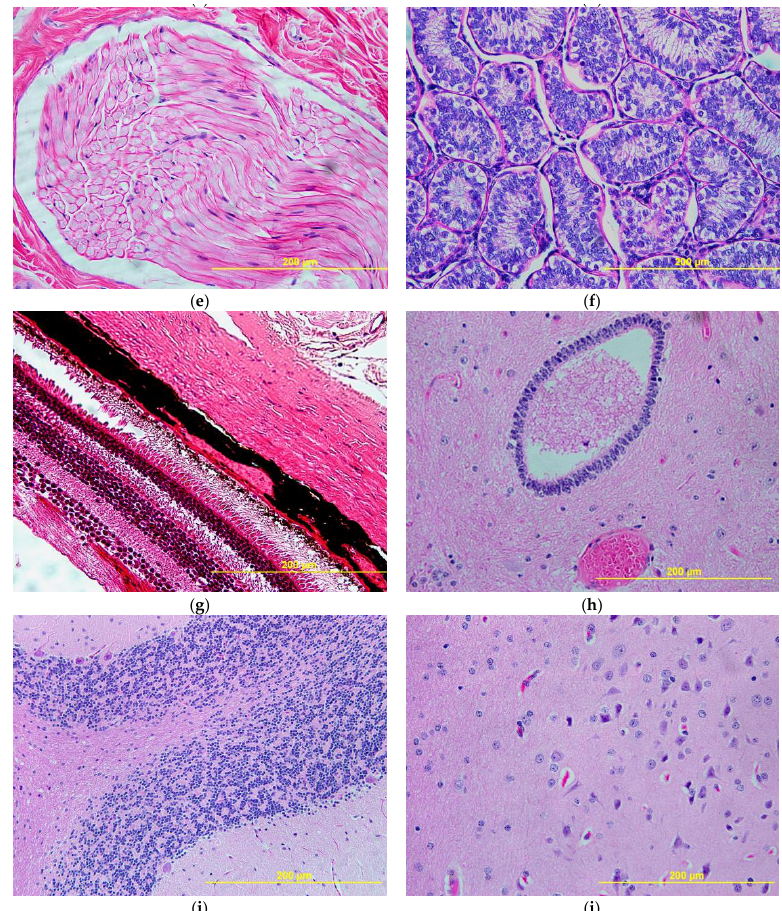
Figure 7. Representative histology from infected cynomolgus macaques. Upon necropsy, no histopathologic changes were noted, except for nonspecific changes related to systemic viremia in lymph nodes and spleen. ( a ) Lymph node: evidence of lymphoid activation and germinal center formation (black circle) with presence of activated lymphocytes, immunoblasts (black arrow) and apoptotic bodies in germinal centers (red arrow). ( b ) Spleen: evidence of lymphoid hyperplasia in periarteriolar lymphoid sheets with prominent germinal center formation (black circle) and presence of activated lymphocytes, immunoblasts (black arrow), and apoptotic bodies (red arrow) in the germinal centers. ( c ) Kidney: glomeruli and renal tubules do not reveal any pathologic changes. ( d ) Liver: hepatocytes are normally glycogenated. Cords and sinusoids do not reveal any evidence of inflammation. Portal triads (not shown) do not show any evidence of inflammation. ( e ) Nerve: spinal cord roots do not show any evidence of degeneration. Myelin stains (not shown) do not reveal any demyelination. ( f ) Testes: seminiferous tubules show normal spermatogenesis. No evidence of interstitial inflammation. ( g ) Eye: the retinal layers are normal. Pigment in the choroid layer is normal. ( h ) Spinal cord: no evidence of inflammation or neuronal cell death. Astrocytes and olygodendrocytes are normal. No evidence of microglial activation. ( i ) Cerebellum: molecular and granular layers are normal. Purkinje cells do not reveal any pathologic changes. ( j ) Cortical tissue of occipital lobe: no evidence of inflammation or neuronal cell death. Astrocytes and olygodendrocytes are normal. No evidence of microglial activation. All images taken at 40 × magnification and 200 µ m scale bar shown in each